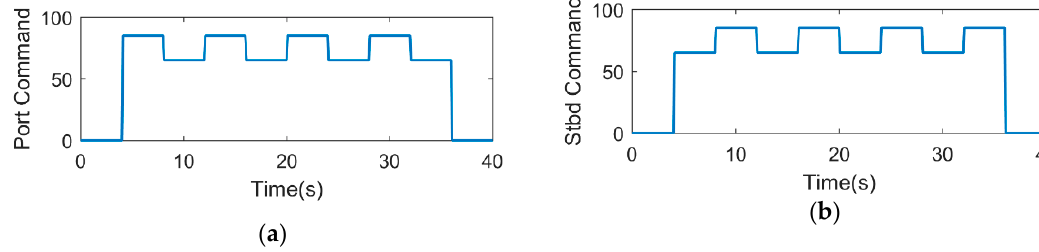
Figure 9. An example of port and starboard motor commands (85%–65%): ( a ) port motor command